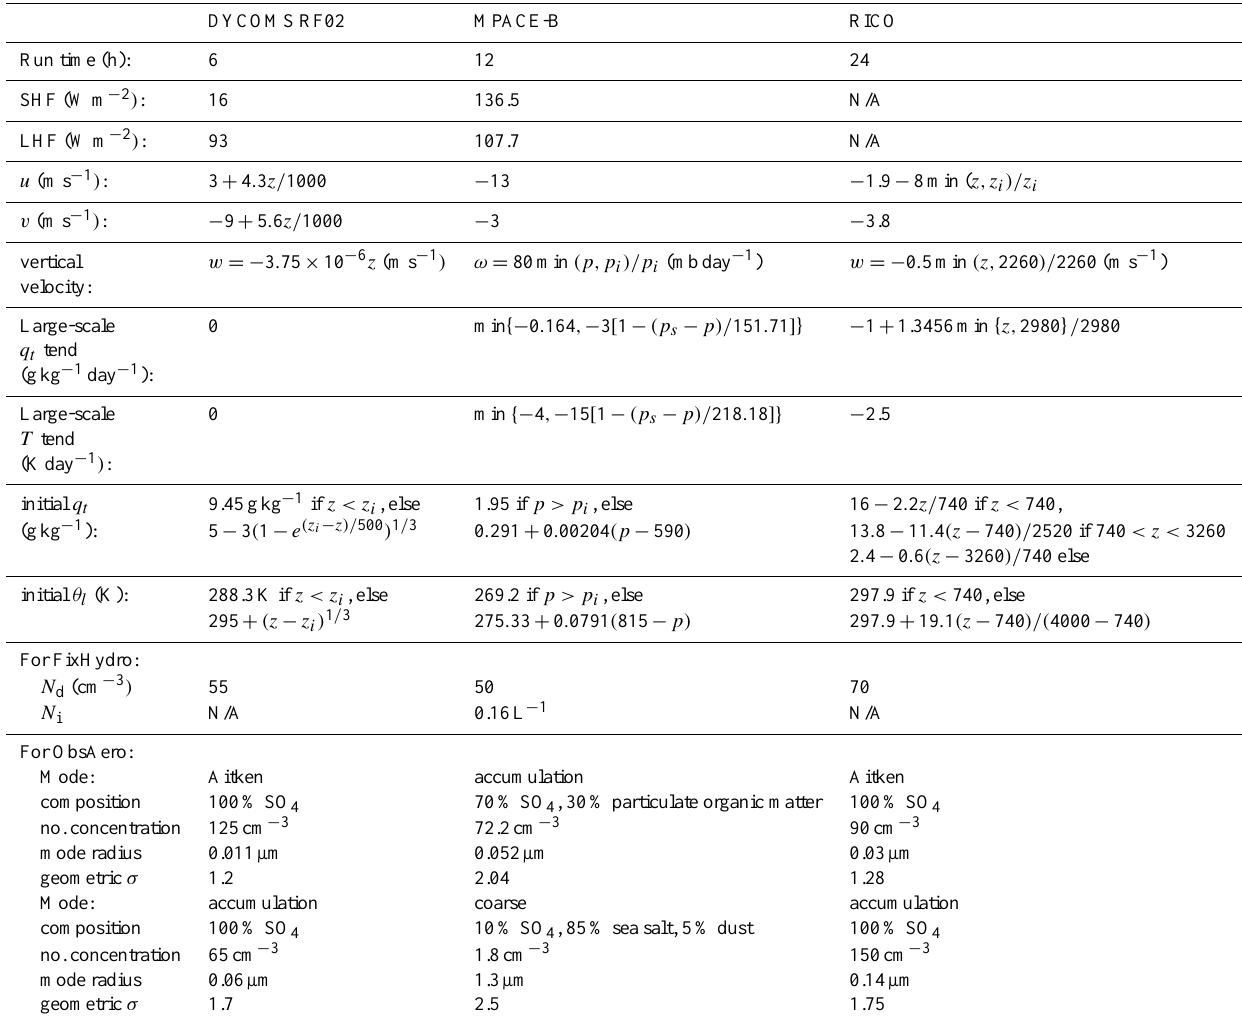
Table 1. Initial and boundary conditions for DYCOMS RF02, MPACE-B, and RICO cases. All heights z are in meters and all pressures p are in hPa. Boundary layer height and vertical velocity are, respectively, z i and w in height coordinates and p i and ω in pressure coordinates. N/A indicates a quantity which is not used or is calculated by the model itself. q t is total water mixing ratio, θ is potential temperature, and θ l is liquid water potential temperature. One of the three aerosol modes for each case is omitted because it has zero mass. DYCOMS RF02 MPACE-B